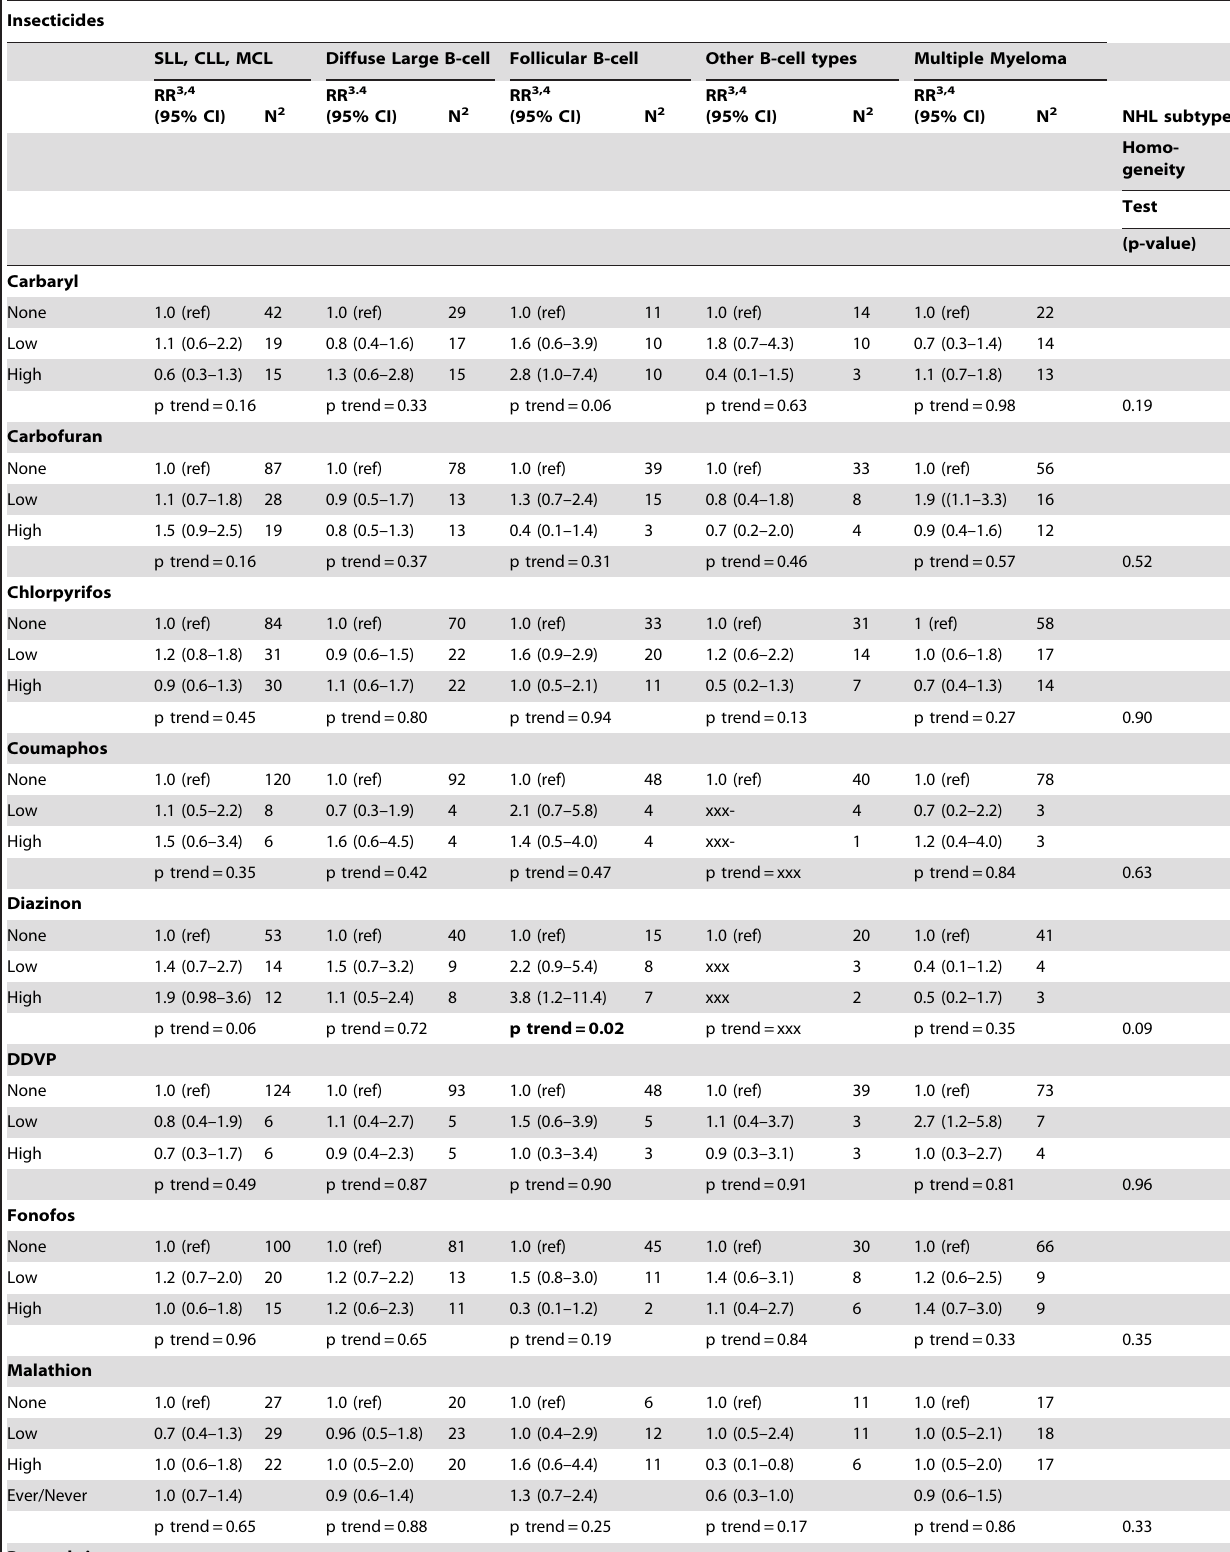
Table 4. Pesticide exposure (Lifetime-Days of Exposure) and adjusted risks for NHL Subtypes.